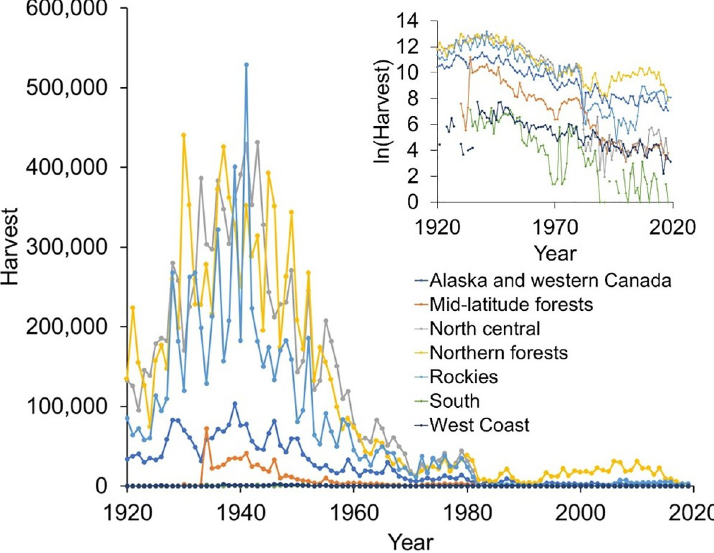
Fig 1. Temporal trends in the annual weasel harvest and natural log-transformed annual weasel harvest (inset) from seven regions within the United States and Canada between 1919 and 2019.